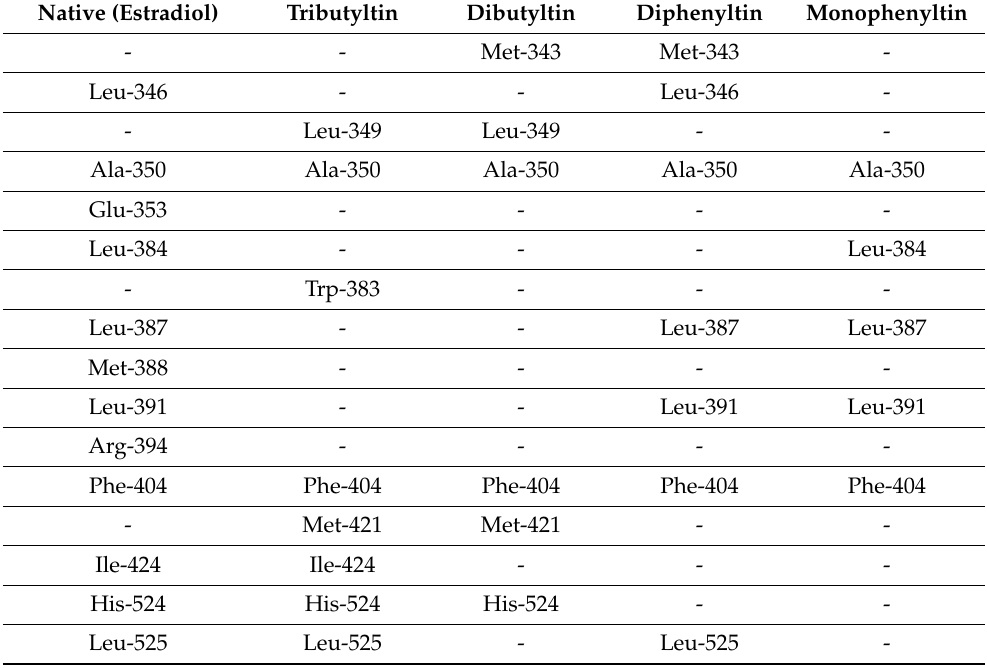
Table 3. Comparative list of amino acid residues of estrogen receptor α interacting with bound native ligand (estradiol), tributyltin, dibutyltin, diphenyltin, and monophenyltin. Residues within a row among native ligand and organotin ligands are overlapping interacting residues for the compounds.